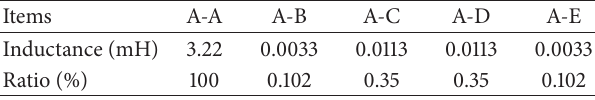
Table 4: Comparison of inductances.